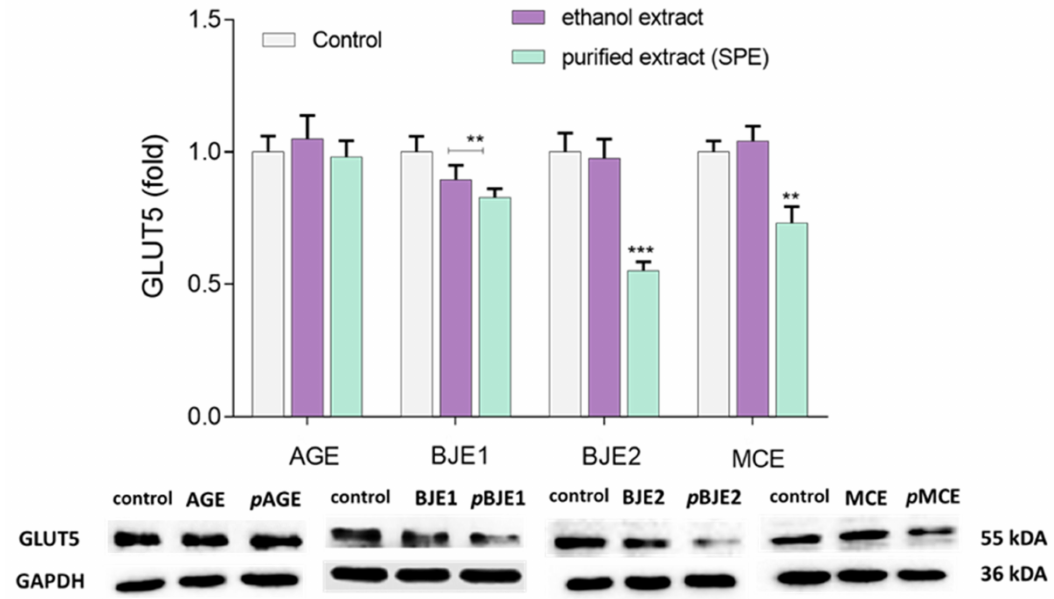
Figure 7. Effect of the ethanolic extracts and the extracts purified with SPE (p) of Apium graveolens (AGE), Matricaria chamomilla (MCE), and Brassica juncea 1/2 (BJE1/2) (0.25 mg/mL) on the relative level of GLUT5 protein in Caco-2 cells after 36-h incubation determined by Western blot analysis control cells were not exposed to any compound (but vehicle); values are means ± standard deviations, n ≥ 4; statistical significance was calculated between treatment and